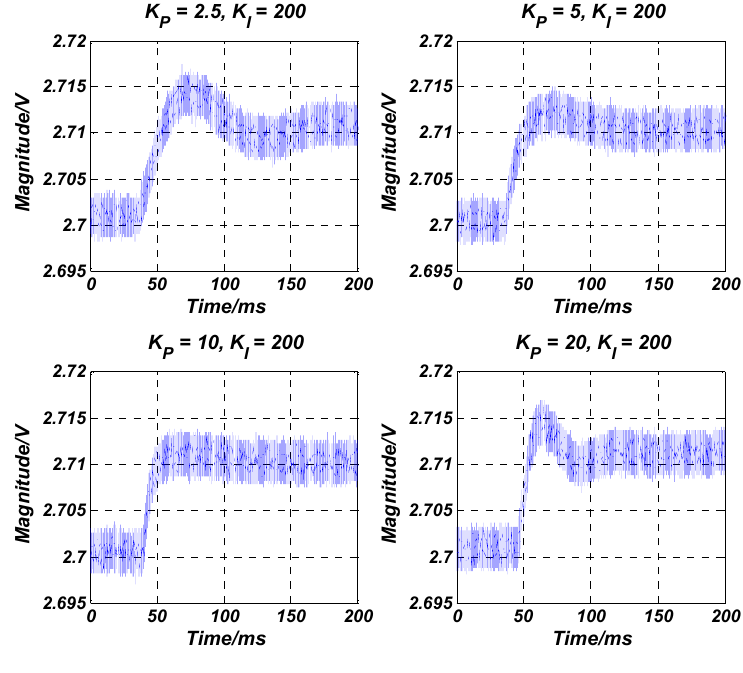
Figure 11. Measured step-up waveforms of the LPF’s output with different proportional terms K P